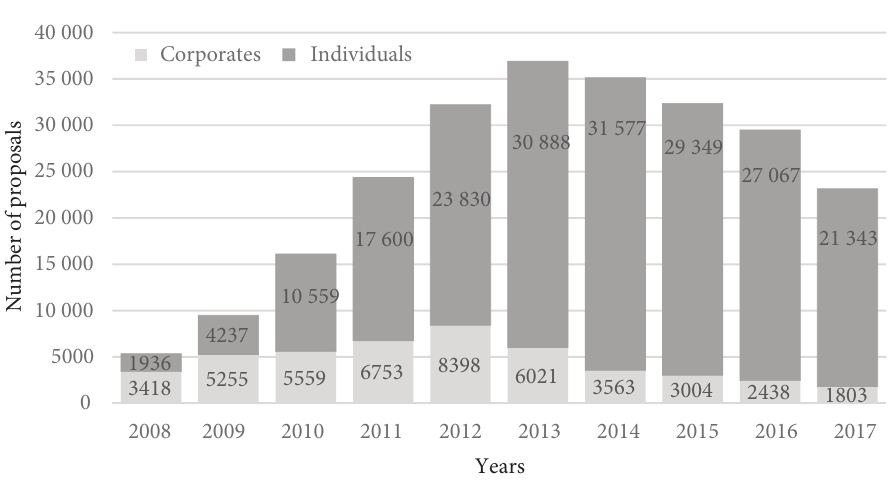
Figure 1. Insolvency in 2008–2017 (source: CreditReform, 2014, 2016,